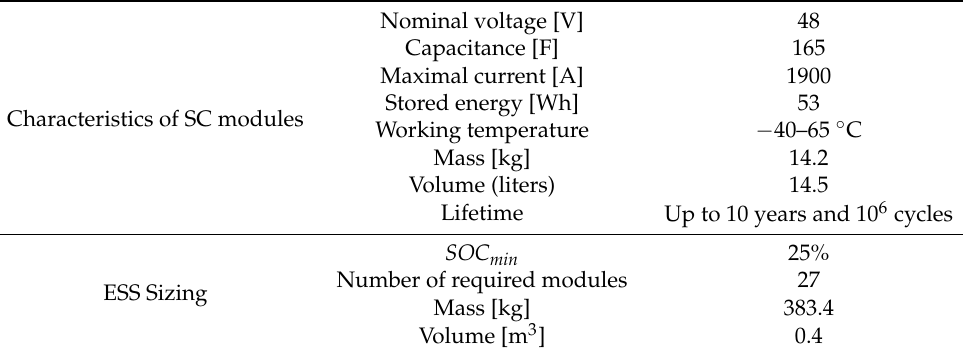
Table 4. Results of the SC ESS